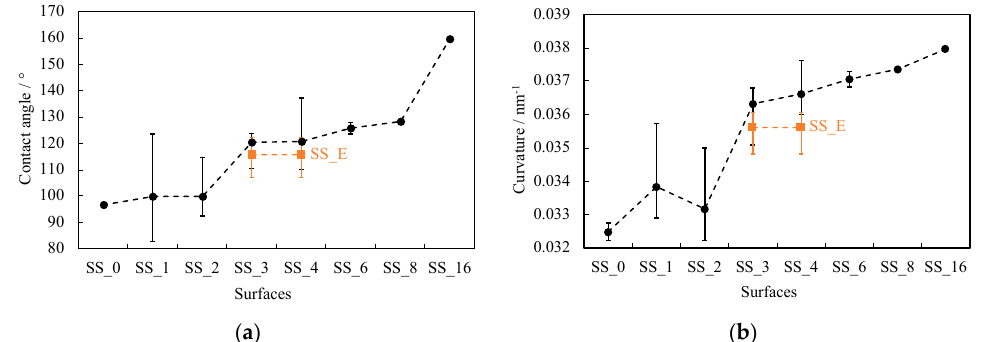
Figure 7. Contact angles and curvatures of the fluid droplet formed over model surfaces. The surfaces that are tested include eight surfaces of various sinusoidal wavelengths (Table 1) and one surface having the roughness of a Ketton rock. Three simulations were performed over each type of surface in which the droplet lands at different ( x , y ) locations on the surface. The ( a ) average contact angle and ( b ) curvature for each sinusoidal surface are plotted with black dots; the uncertainty associated with the data points are indicated with black error bars. These data points are benchmarked against the case when the surface topology resembles that of the Ketton surface, which is shown in orange squares and labeled with SS_E. The corresponding error span is also plotted in orange. Dashed lines are used to guide the eye.